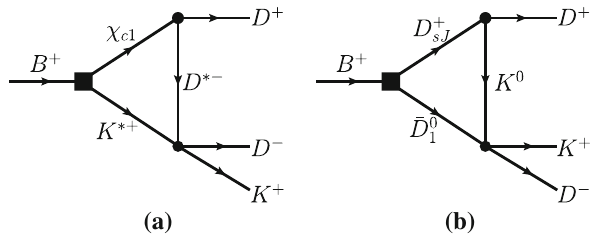
Fig. 1 B + → D + D − K + viathetrianglerescatteringdiagrams.Kine- matic conventions for the intermediate states are a K ∗+ ( q 1 ) , χ c 1 ( q 2 ) , D ∗− ( q 3 ) and b ¯ D 0